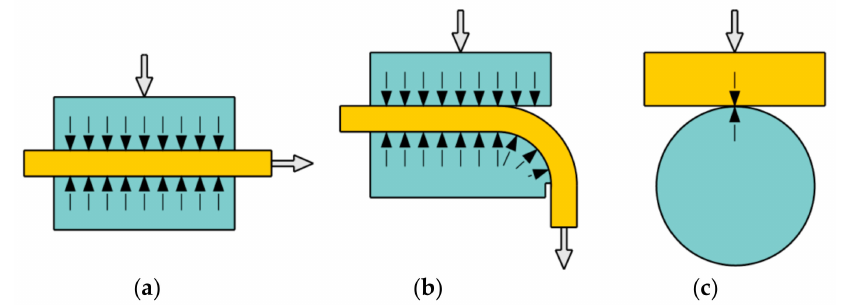
Figure 3. Types of sheet-tool contact: ( a ) flat contact, ( b ) sliding over a curved part of the tool, and ( c ) linear sliding contact.